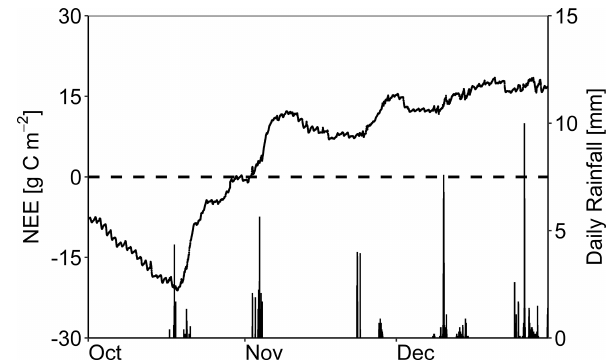
Figure 9. Relative humidity (RH) and sensible heat (SHF) and NEE fluxes with a 1min resolution during the morning hours of 28 September 2017, indicating dew formation followed by evap- oration of dew and associated CO 2 emission between 06:30 and 07:30UTC.